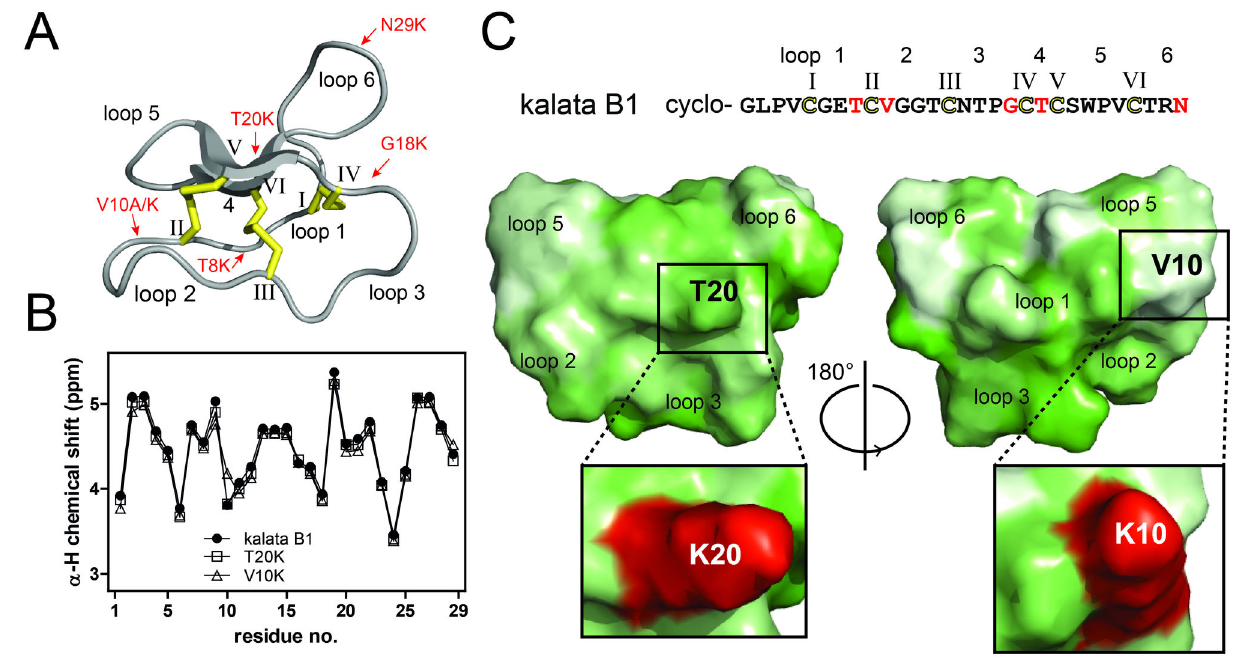
Figure 1. Structure of kalata B1 and cyclotide mutants. The structure of kalata B1 is shown in cartoon form ( A ). The six conserved cysteines are labeled with Roman numerals and the cystine knot disulfide connectivity (C indicated. The amino acid sequence and the loops of the kalata B1 backbone are shown in C. The positions of the mutations are indicated by red arrows in the cartoon and are highlighted with red letters in the sequence. The α-H chemical shift comparison of kalata B1 (full circles), [V10K] kalata B1 (open triangles) and [T20K] kalata B1 (open squares) is shown for all residues starting from residue G1 ( B ). The amino acid sequence (with mutations highlighted in red) and a surface representation of kalata B1 (PDB code: 1NB1) is shown in ( C ). The structure is using a hydrophobicity scale according to Eisenberg et al. [53] to illustrate the amphiphilic nature of these peptides. Typical hydrophilic regions of cyclotides are in loops 2 and 3, whereas the hydrophobic patch is found on the opposite site in loops 5 and 6. Mutated amino acids, e.g., in [V10K] and [T20K] kalata B1 were modeled using the PyMol mutation wizard and have been shown in red color in the enlarged window. All Figure representations were prepared using PyMol. doi: